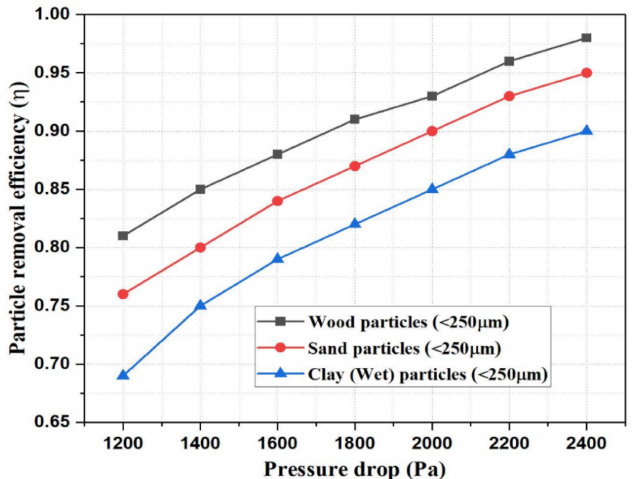
Figure 12. Experimental results of the effect of pressure drop on particle suction